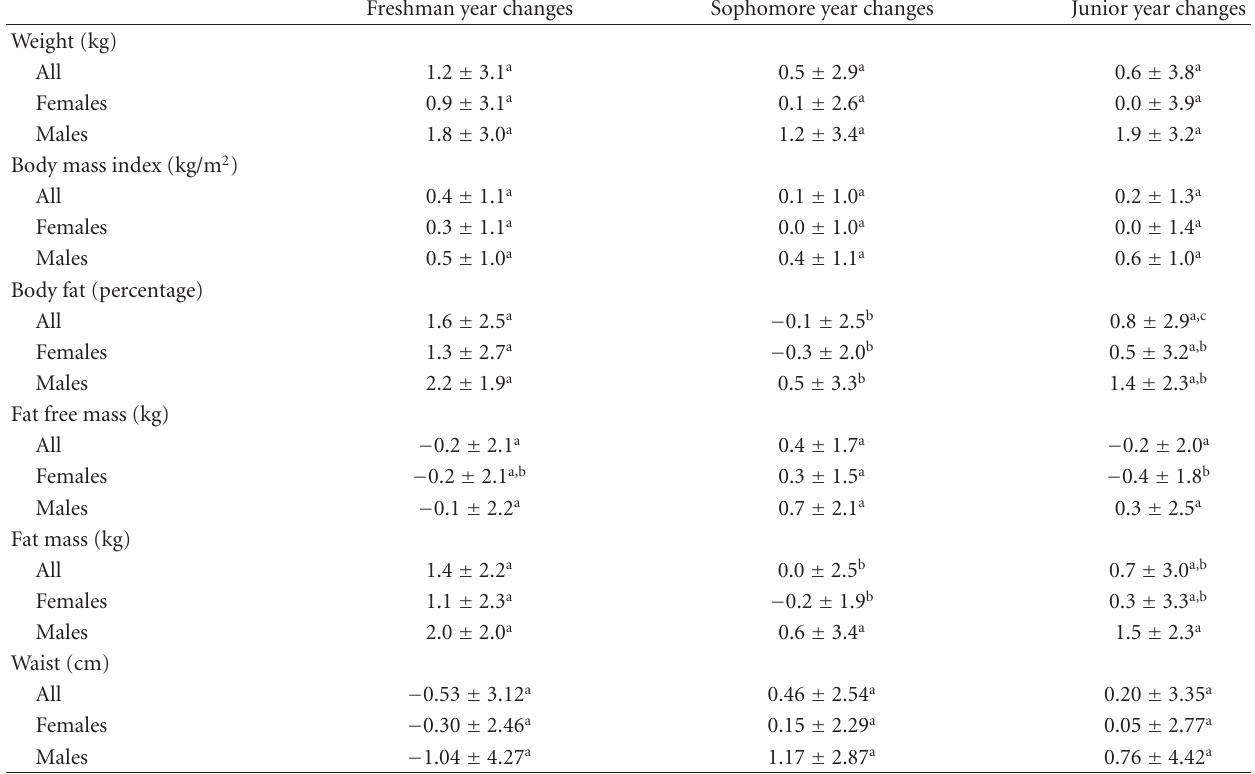
Table 1: Freshman, sophomore, and junior year changes in weight, body mass index, and body composition.